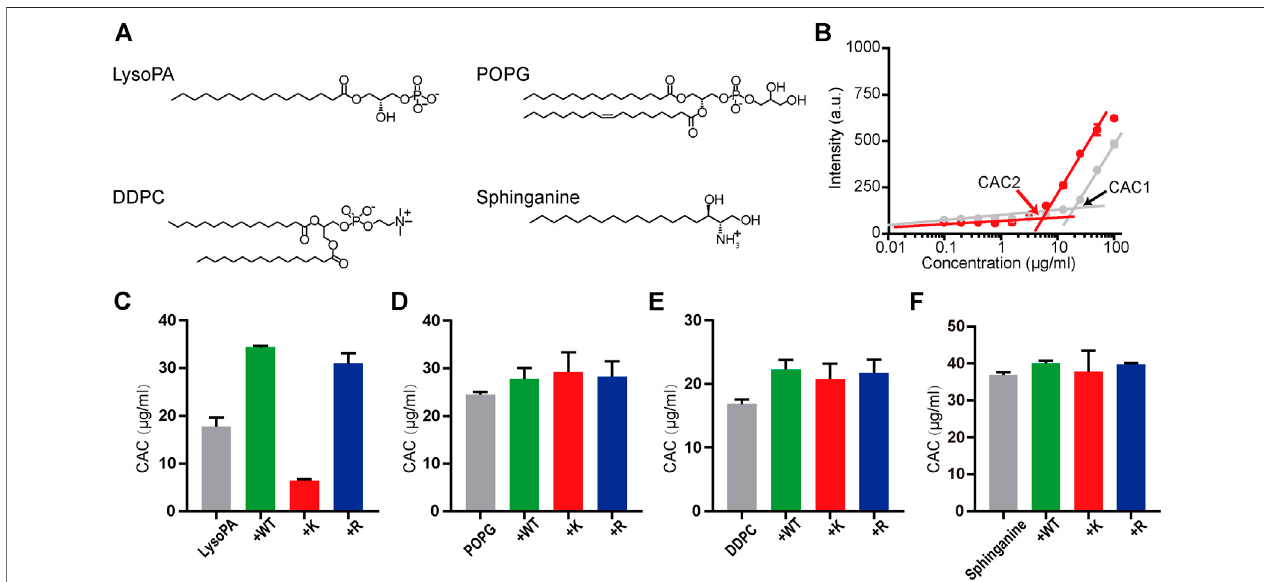
FIGURE 3 | The molecular recognition of melittins with lipids. (A) The chemical structures of LysoPA, POPG, DDPC, and sphinganine. (B) The CAC values of LysoPA are determined from the DPH fl uorescence data. The gray dots represent the DPH fl uorescence of LysoPA at different concentrations, and the red dots representtheDPH fl uorescenceoflipidsinteractingwith6 μ Mmelittin-K. (C – F) The CAC diagramsofdifferentlipidsinteractingwithmelittinpeptides.Dataarepresented as means ± SD ( n (cid:2)